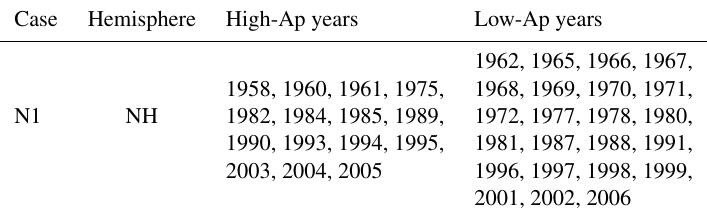
Table 1. Years used to define the N1 set, following